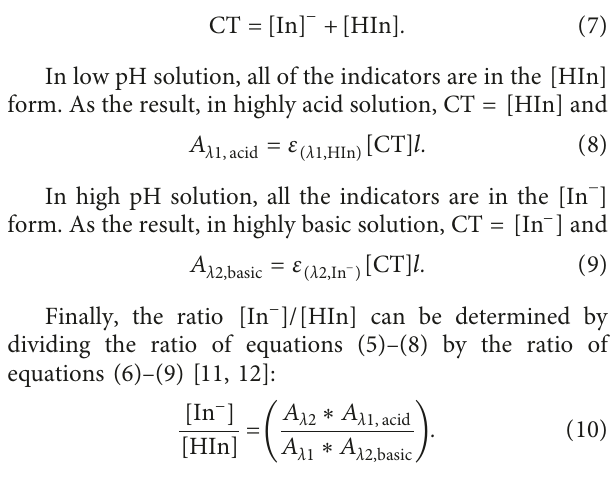
2 HPO 4 solution and 0.1M